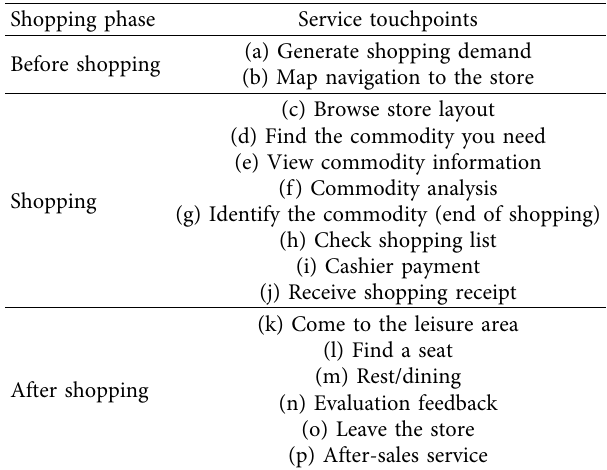
Table 2: Summary of service touchpoints of convenience store